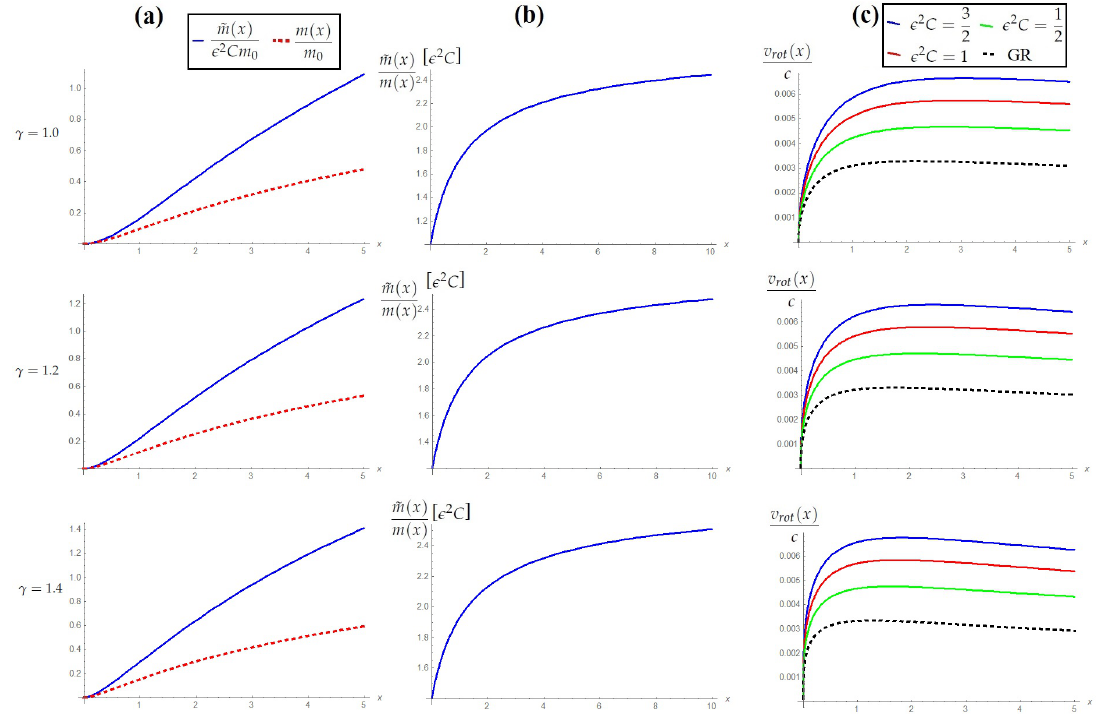
Figure 4. Navarro–Frenk–White (NFW) Profile Calculation for γ = { 1,1.2,1.4 } . ( a ) ordinary and δ Matter vs. normalized radius, with m 0 = 8 π R 3 ρ 0 . We have that more δ Matter is accumulated from the center, just like the exponential and Einasto cases; ( b ) ˜ m ( x ) (in units of (cid:101) 2 C ) vs. normalized radius. Compared with the other m ( x ) profiles, we have that ˜ m ( x ) increases faster than m ( x ) , but, in this case, the relation between both masses is practically logarithmic; ( c ) rotation velocity vs. normalized radius for different values of (cid:101) 2 C . The Black-Dashed line corresponds to GR cases and the other (cid:101) 2 C values indicate the contribution of δ Matter. Here, we verify the result in the other profiles, δ Matter amplifies the rotation velocity, such that, if (cid:101) 2 C is bigger, we have higher velocities. 3 − γ × 10 − 4 In these calculations, we have used κρ 0 R 2 = ( 3 − γ ) 4 ( 2 − γ ) 2 − γ